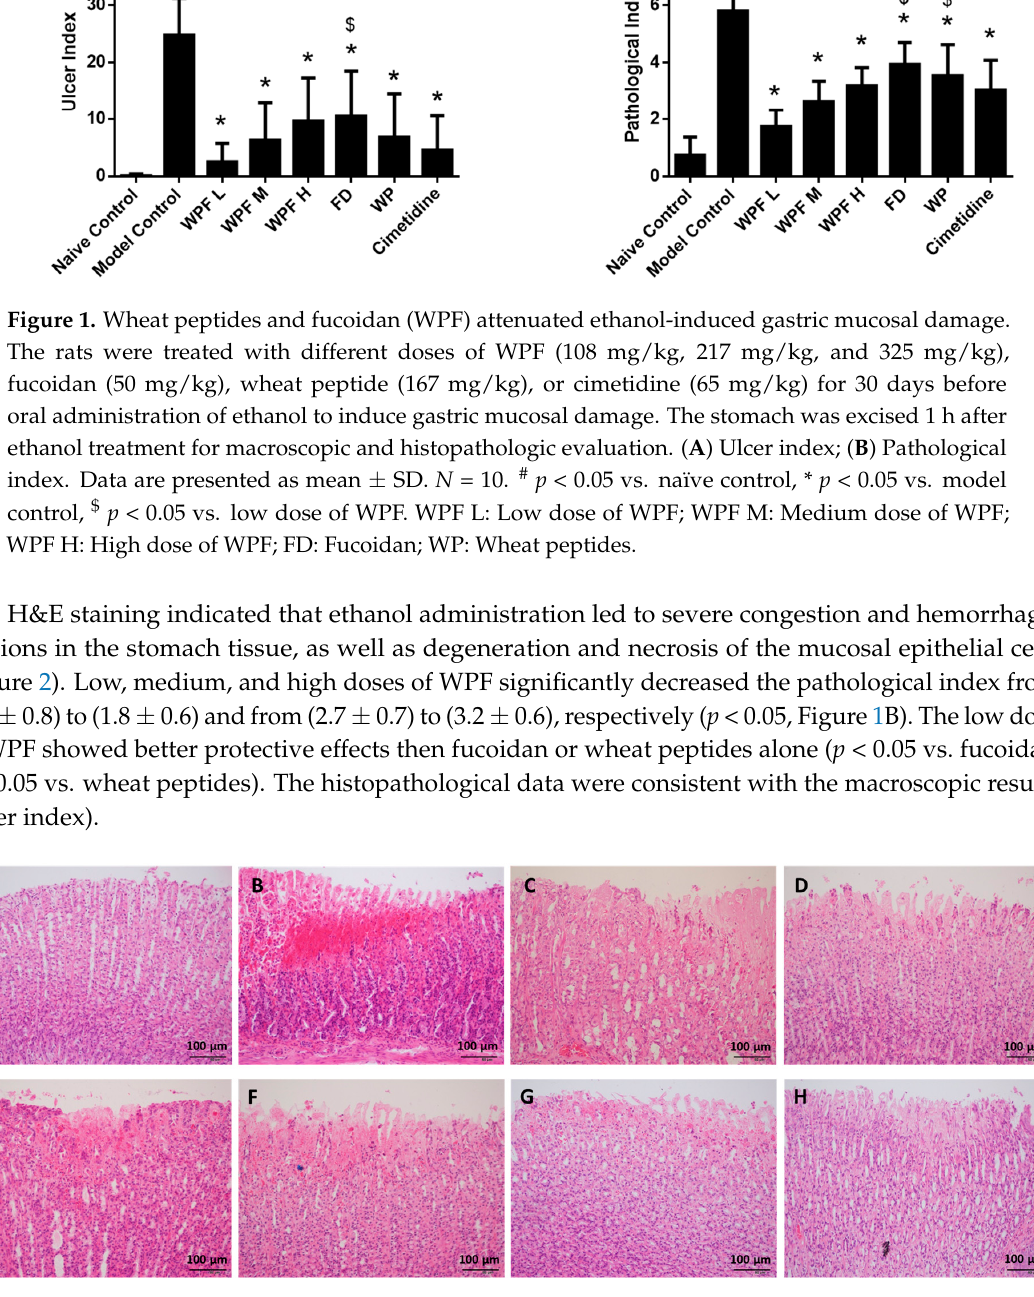
Figure 2. Representative photos of histopathologic evaluation. The stomach tissue was fixed in 10% formaldehyde, embedded into paraffin, and cut into 4 μ m sections for hematoxylin-eosin (H&E) staining. ( A ) Naïve control; ( B ) Model control; ( C ) Low dose of WPF (108 mg/kg); ( D ) Medium dose of WPF (217 mg/kg); ( E ) High dose of WPF (325 mg/kg); ( F ) Fucoidan (50 mg/kg); ( G ) Wheat peptide (167 mg/kg); ( H ) Cimetidine (65 mg/kg).